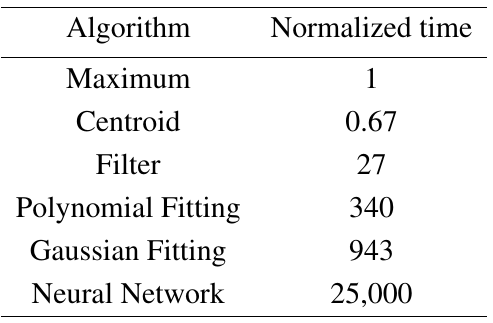
Table 1. Computational performance of the evaluated